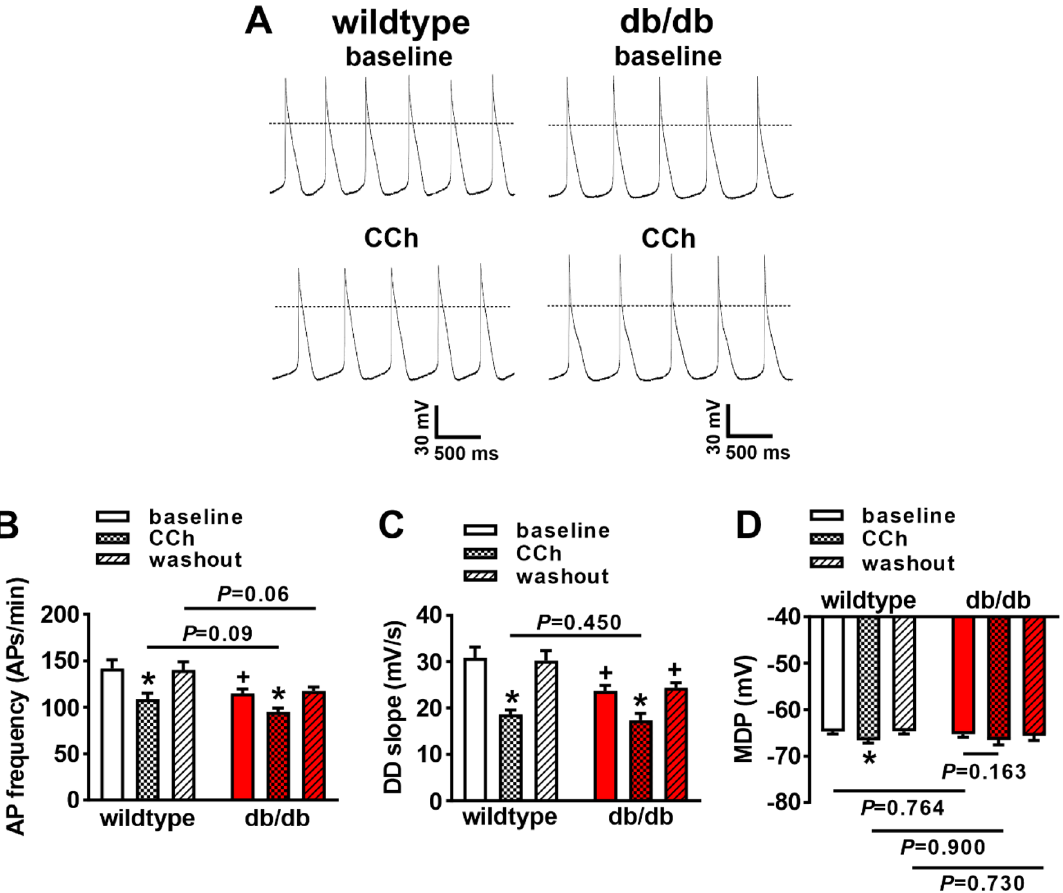
Figure 3. Effects of carbachol on spontaneous action potential firing in isolated sinoatrial node myocytes from db/db mice. ( A ) Representative spontaneous APs at baseline and after CCh (50 nM) in wildtype and db/db SAN myocytes. Dashed lines are at 0 mV. ( B ) Summary of spontaneous AP frequency at baseline and after CCh in wildtype and db/db SAN myocytes. ( C ) Summary of DD slope at baseline and after CCh in wildtype and db/ db SAN myocytes. ( D ) Summary of maximum diastolic potential (MDP) at baseline and after CCh in wildtype and db/db SAN myocytes. For panels ( B – D ) n = 14 wildtype and 13 db/db SAN myocytes; * P < 0.05 vs baseline; + P < 0.05 vs wildtype by two-way ANOVA with Holm–Sidak posthoc